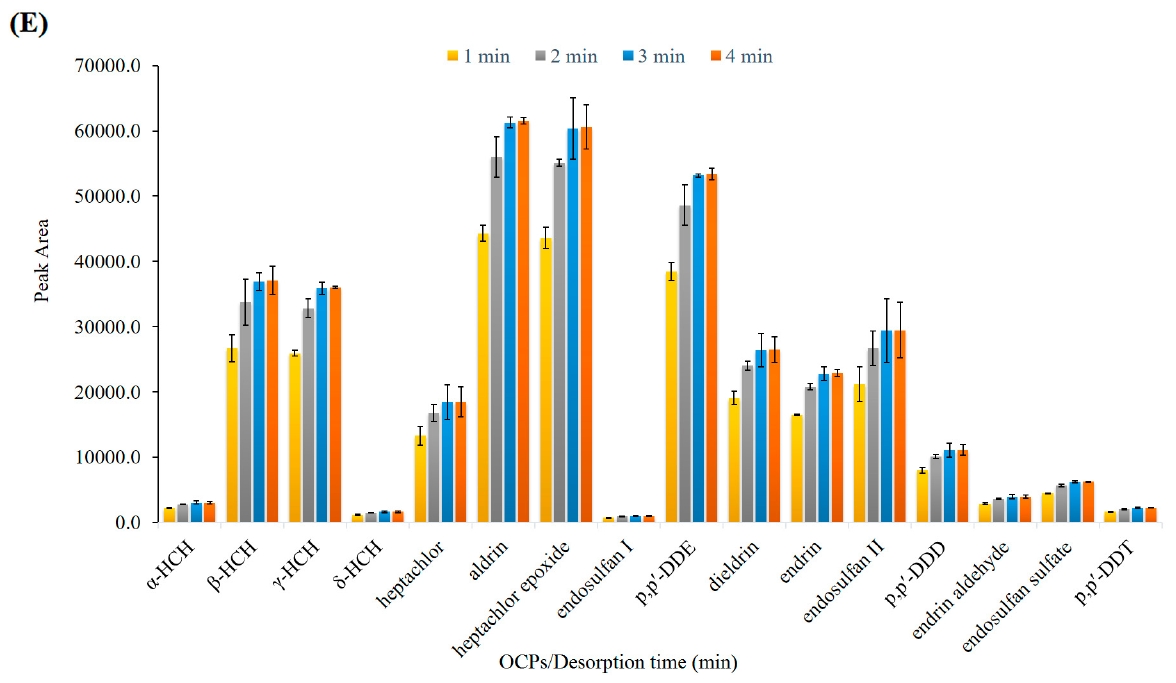
Figure 5. Optimization of effective parameters on extraction efficiency of OCPs. ( A ) Effect of salt ( w / v %), ( B ) extraction temperature (°C), ( C ) extraction time (min), ( D ) desorption temperature (°C), and ( E ) desorption time (min).